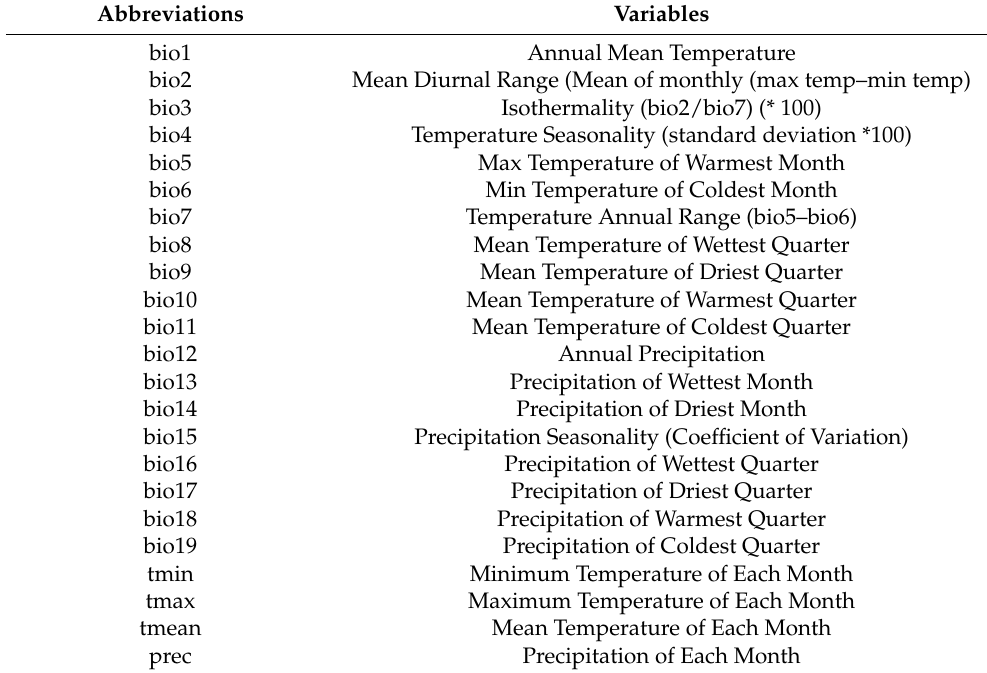
Table 1. List of environmental